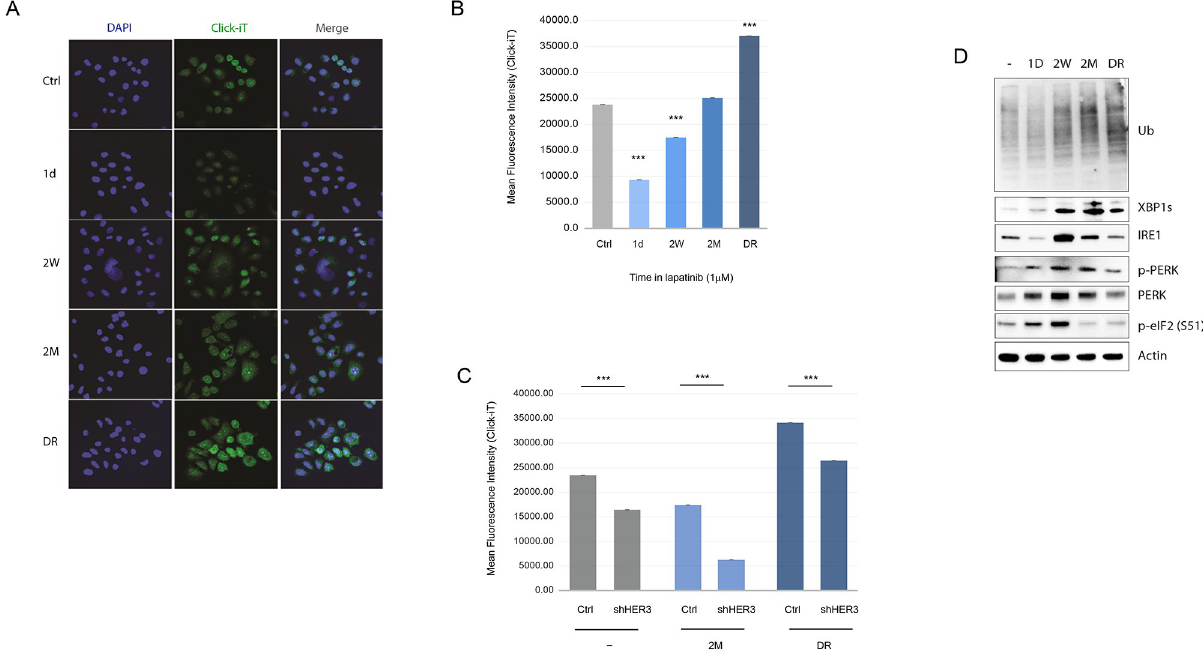
Fig 3. Protein homeostasis dynamics during the course of chronic lapatinib treatment. A) Immunofluorescence images of at the indicated stages of 1 μ M lapatinib treatment stained for newly synthesized proteins within a 30 min window using the Click-iT Protein Synthesis assay. B) Flow cytometry- based measurement of protein synthesis using the same conditions as in A using the Click-iT assay. Data is presented as mean fluorescence intensity (MFI). C) Protein synthesis rate measurement as in (B) in the indicated conditions with and without Her3 silencing. D) Western blots of the indicated ER stress response markers in the indicated conditions. Statistics: error bars show standard deviations of 2 (B-C) replicates. The data are representative of at least 2 independent experiments. ��� : P < 0.01 with student’s t-test. Densitometric quantitation of the immunoblotting data are provided in